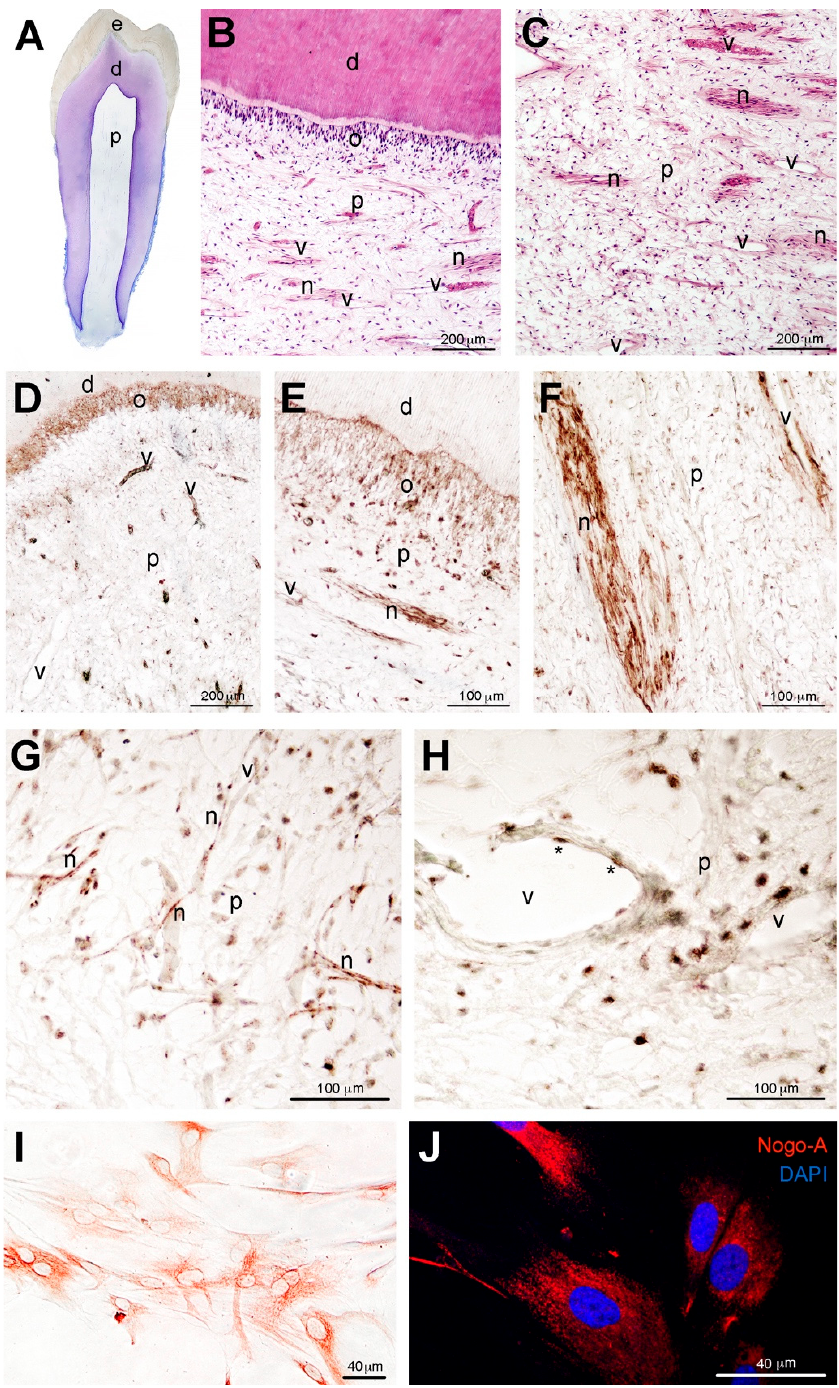
Figure 2. Nogo-A protein distribution in the dental pulp of human adult teeth and in cultured human dental pulp stem cells (hDPSCs). ( A ) Hematoxylin and Eosin (H&E) stained histological section of a human first premolar. ( B , C ) Histological sections of human adult teeth stained with H&E, showing the various components of the dentin-pulp complex. ( D – H ) Immunostaining showing the distribution of Nogo-A (brown color) in odontoblasts ( D , E ), pulp fibroblasts ( E , G , H ), vessels ( D , F , H ) and nerves ( E , F , G ) of human teeth. Asterisks in ( H ) indicate endothelial cells. ( I ) Nogo-A immunostaining (brown/red color) in cultured hDPSCs. ( J ) Nogo-A immunofluorescence staining (red color) in hDPSCs. DAPI (blue color) marks the nuclei of the cells. Abbreviations: d, dentin; e, enamel; n, nerves; o, odontoblasts; p, dental pulp; v, vessels.